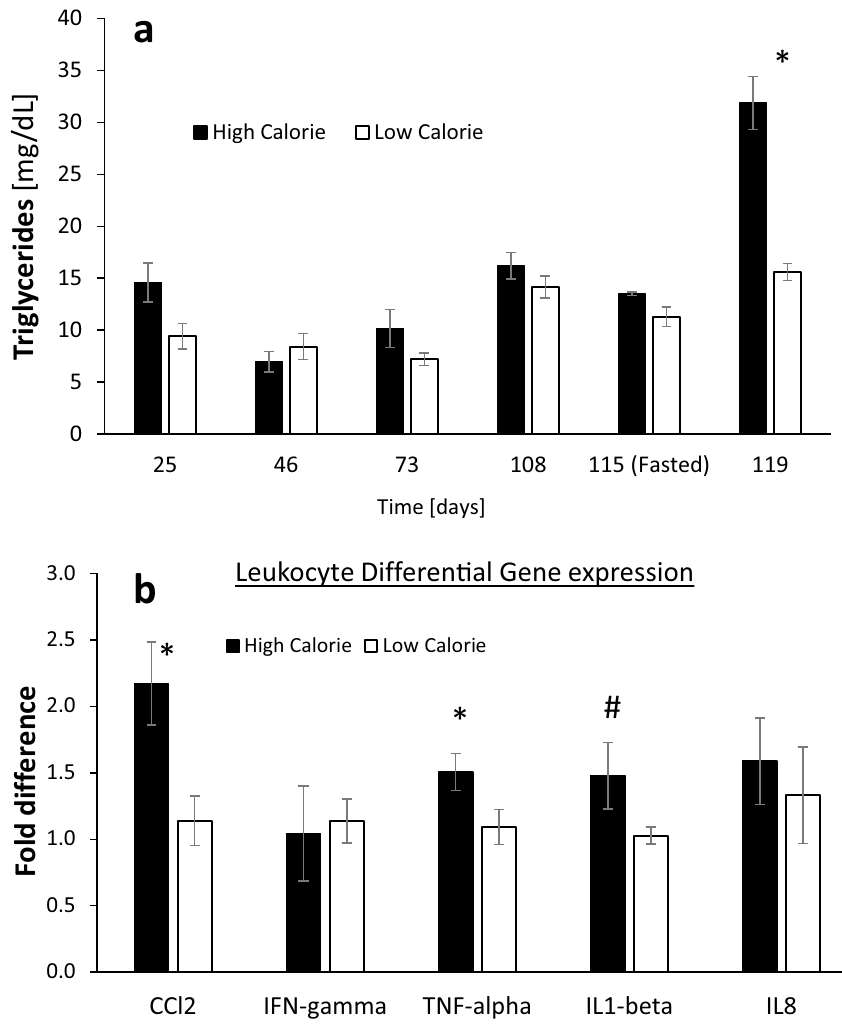
Figure 3. Triglycerides and inflammatory markers in response to the high- and low-calorie dietary treatments. ( a ) Plasma triglycerides concentrations. Repeated measures ANOVA shows an effect of treatment ( P < 0.0013), time ( P < 0.0001), treatment by time interaction ( P < 0.01). SEM = 0.716. Due to unequal variances between treatments, the statistical analysis was performed on the log-transformed values. Data for fasting levels were not included in the ANOVA, and analyzed independently by a Student’s t-test at a * P < 0.05 significance level and Bonferroni-Holm correction. ( b ) Differential gene expression analysis in circulating leukocytes. Student’s t-tests * CCL2 P < 0.01, * TNF-alpha P < 0.04, # IL1B P <